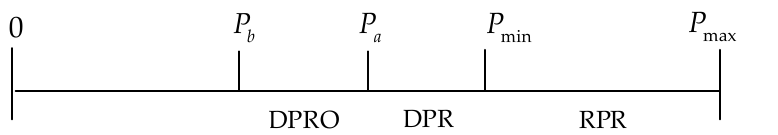
P is the maximum max